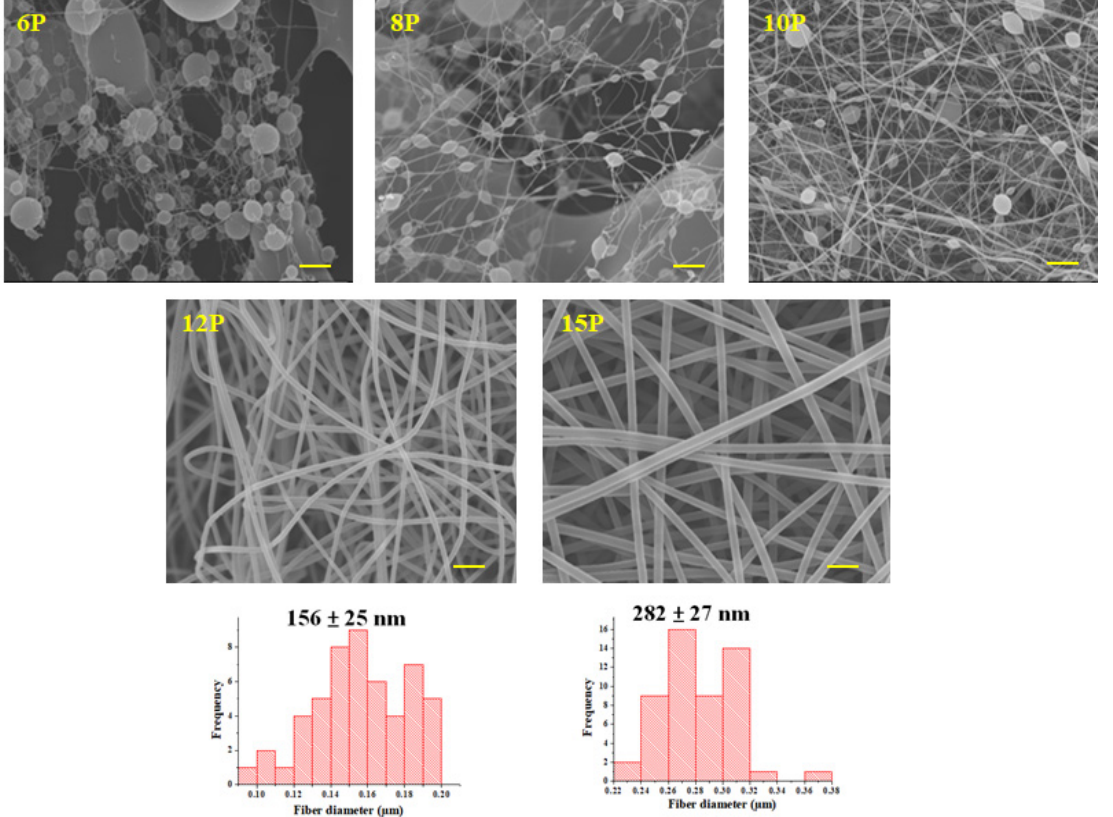
Figure 2. SEM images of pullulan nanofibers (6–15% w/w ) showing the morphology and diameter distributions: 6P: 6% pullulan; 8P: 8% pullulan; 10P: 10% pullulan; 12P: 12% pullulan and 15P: 15% pullulan. Scale bar 1 μ m; 10,000×.